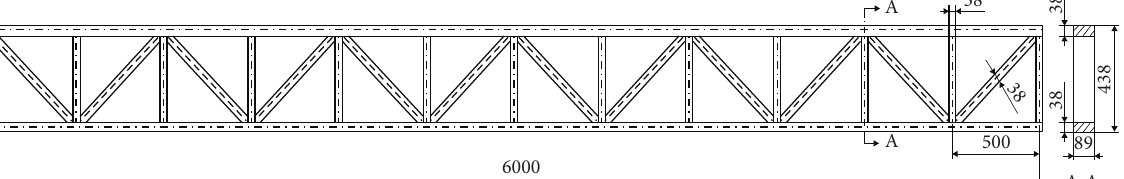
Figure 1: Typical parallel flange timber truss.